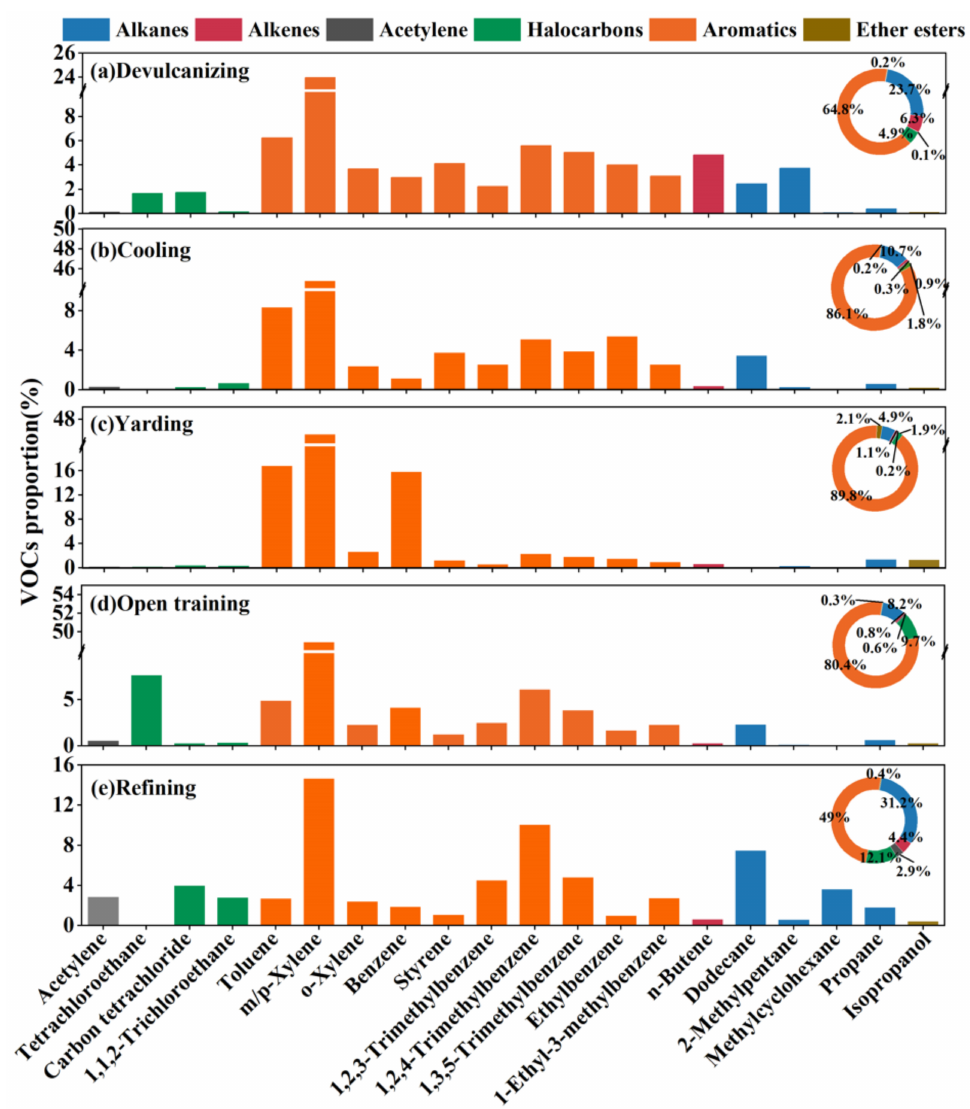
Figure 2. VOCs source profiles for the recycling plant Note: species included in the bar graph were in the top ten of the total concentrations of each profile, while the ring charts contain all measured